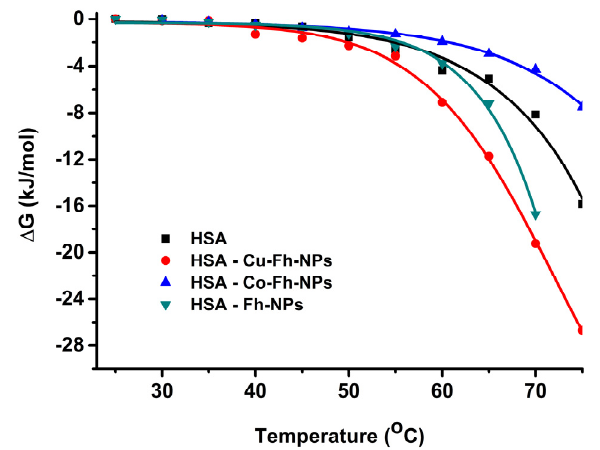
Figure 6. The variation of the Gibbs free energy, Δ G, for HSA ( ■ ), HSA-Fh-NPs ( ▼ ), HSA-Co-Fh-NPs ( ▲ ), and HSA-Cu-Fh-NPs ( ● ), in 100 mM HEPES, at pH 7.25.